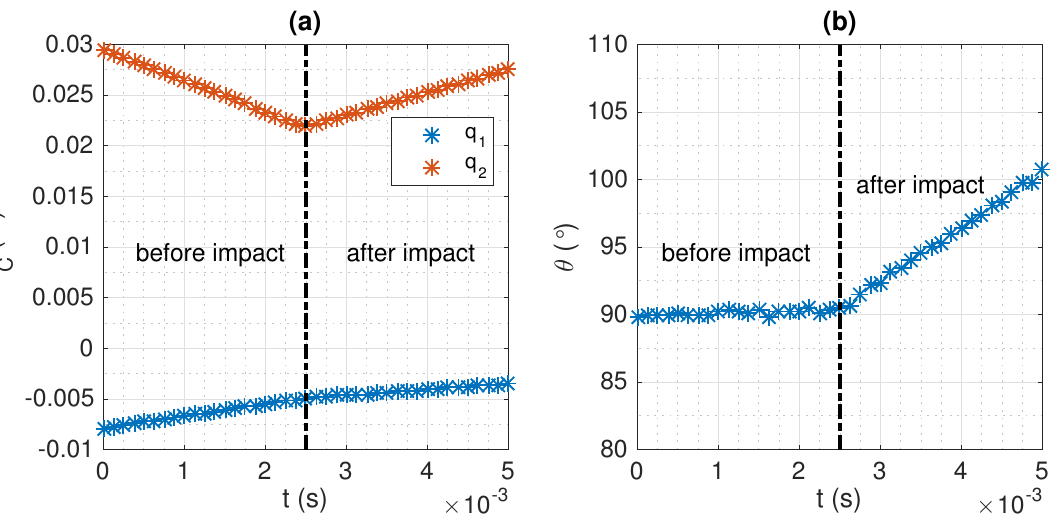
Figure 3. Displacement of the hoof wall before and after impact in local coordinates q 1 , q 2 , q 3 ( a ) displacement of the center of mass ( b ) angular